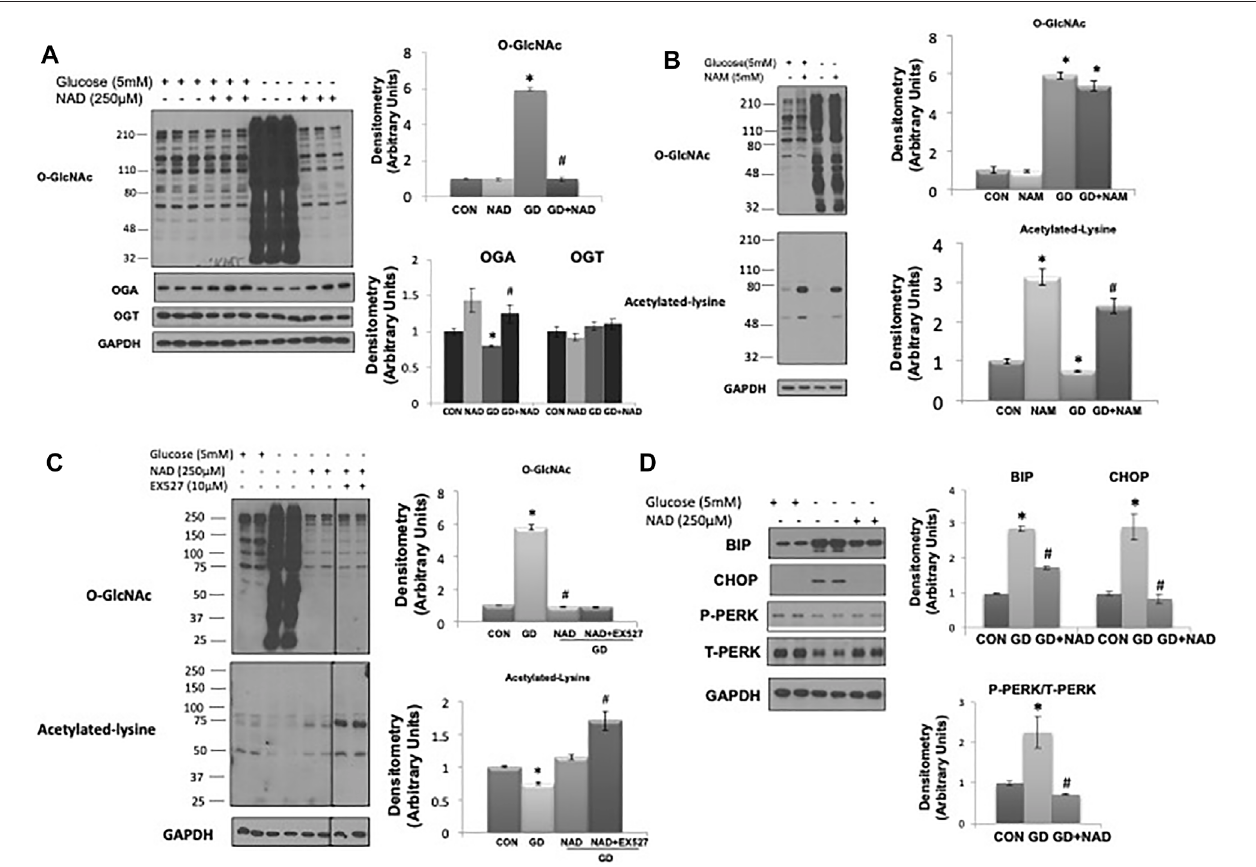
FIGURE 1 | Effects of NAD + on O-GlcNAc levels and ER stress in response to glucose deprivation in AC16 cells. (A) Left panel: O-GlcNAc, OGA and OGT immunoblots, with and without glucose (5 mM) and NAD + (250 µM). Right panel: Quanti fi cation of immunoblots normalized to GAPDH. (B) Left panel: O-GlcNAc and acetylated lysine immunoblots, with and without glucose (5 mM) and nicotinamide (NAM, 5 mM). Right panel: Quanti fi cation of immunoblots normalized to GAPDH. (C) Left panel: Effects of SIRT1 inhibitor EX527 (10 µM) on O-GlcNAc and acetylated lysine levels in response to glucose deprivation with NAD + . Right panel: Quanti fi cation of immunoblots normalized to GAPDH. (D) Left panel: BiP, CHOP, phospho- (P) and total (T) PERK immunoblots, with and without glucose (5 mM) and NAD + (250 µM). Right panel: Quanti fi cation of immunoblots normalized to GAPDH. * p < 0.05 vs. Control (Con) group; # p < 0.05 vs. glucose deprivation (GD) group. All data are expressed as mean ± S.E.M. of 3 – 6 independent